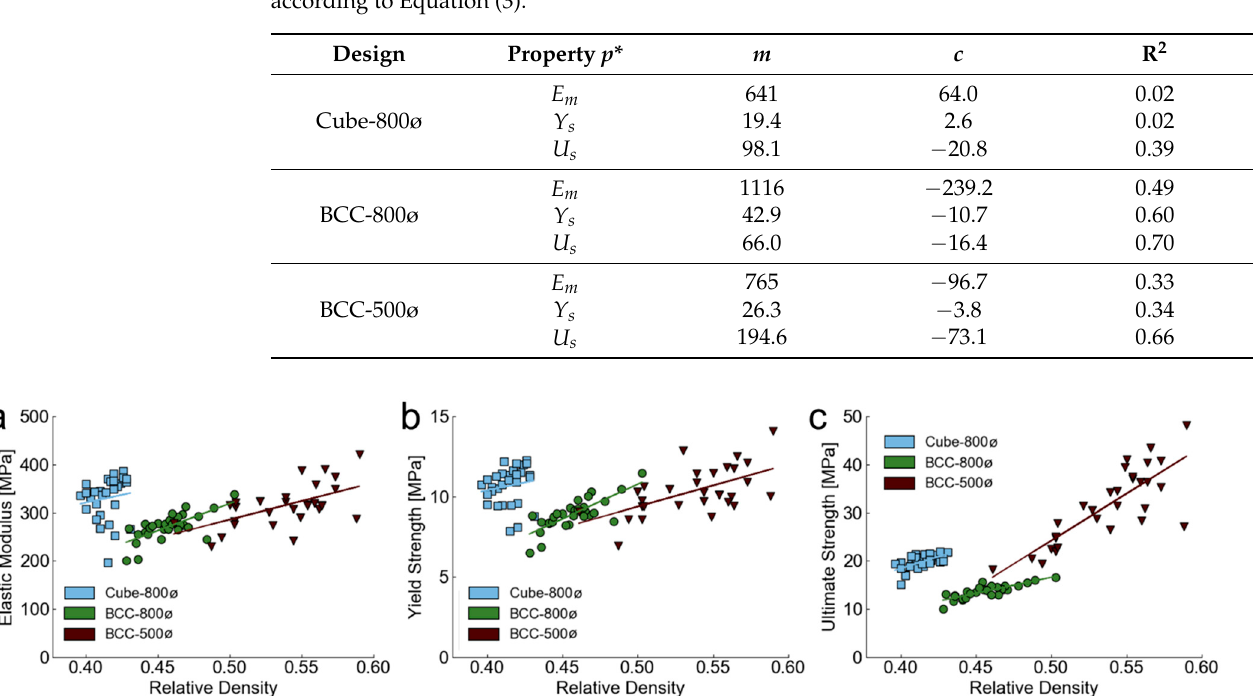
Table 2. Linear regression values with correlation coefficient for mechanical properties of each design, according to Equation (3).